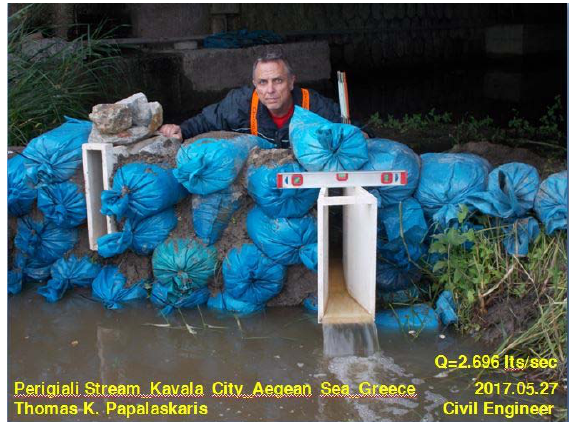
Figure 2. Parshall flumes and V ‐ Notched weir gauging station, Perigiali Stream area, Kavala city, Greece, (see Supplementary Materials).